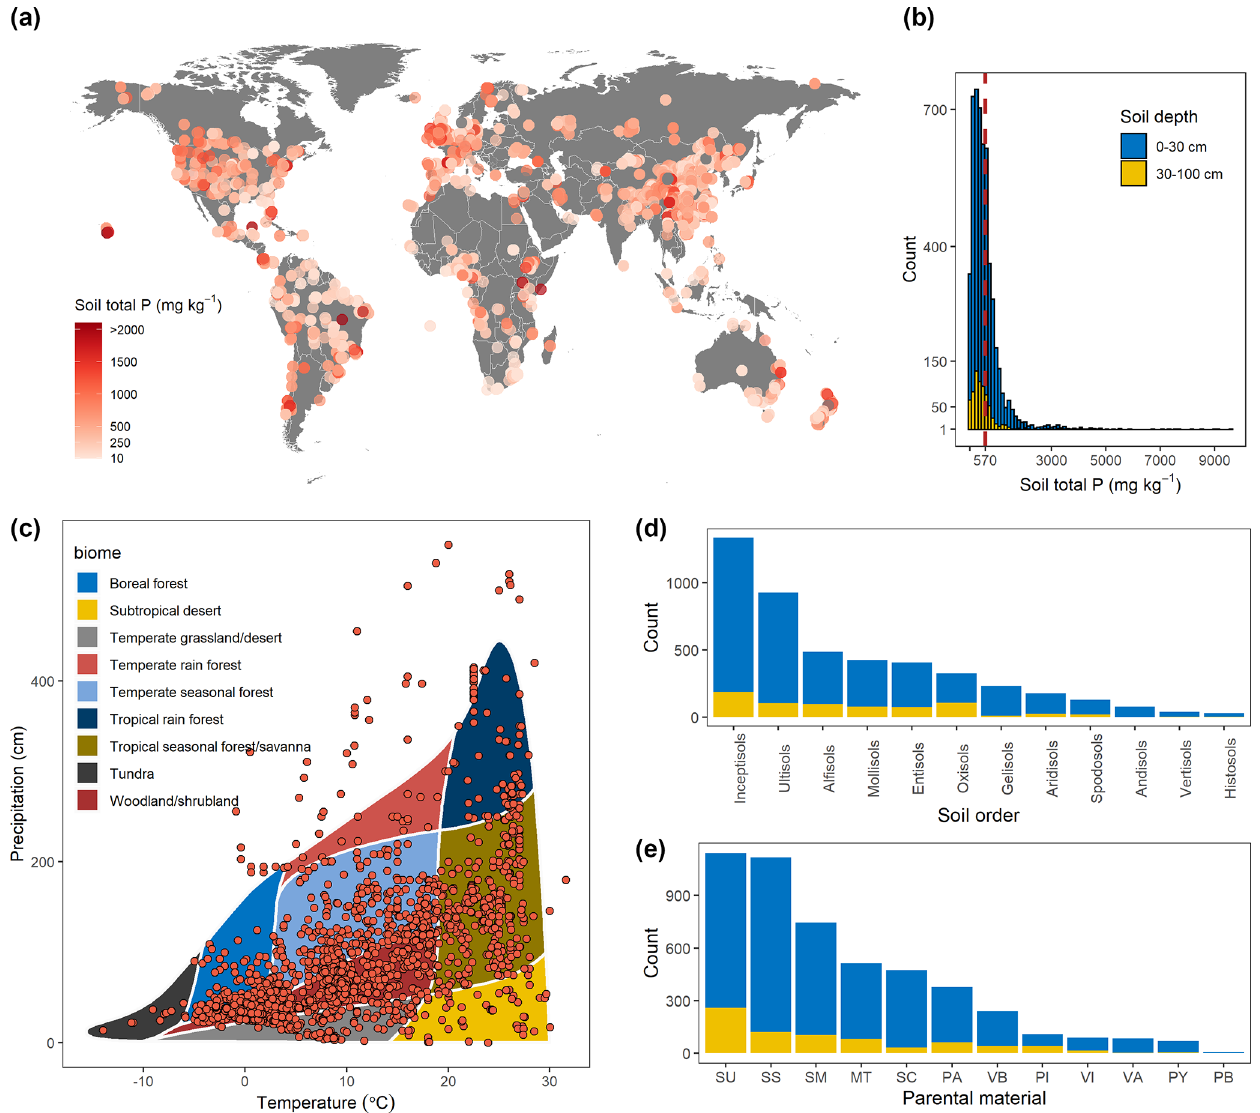
Figure 1. The distribution of our site-level training data. The database contains 5275 observations (a, b) covering all major terrestrial biomes (c) , 12 soil orders (d) , and 12 parent materials (e) . The dashed red line in panel (b) indicates the arithmetic mean of the soil total P concentration (570mgkg − 1 ). The abbreviations in panel (e) represent the following: SU, unconsolidated sediments; SS, siliciclastic sedimentary; SM, mixed sedimentary; MT, metamorphics; SC, carbonate sedimentary; PA, acid plutonic; VB, basic volcanic; PI, intermediate plutonic; VI, intermediate volcanic; VA, acid volcanic; PY, pyroclastics; PB, basic plutonic.